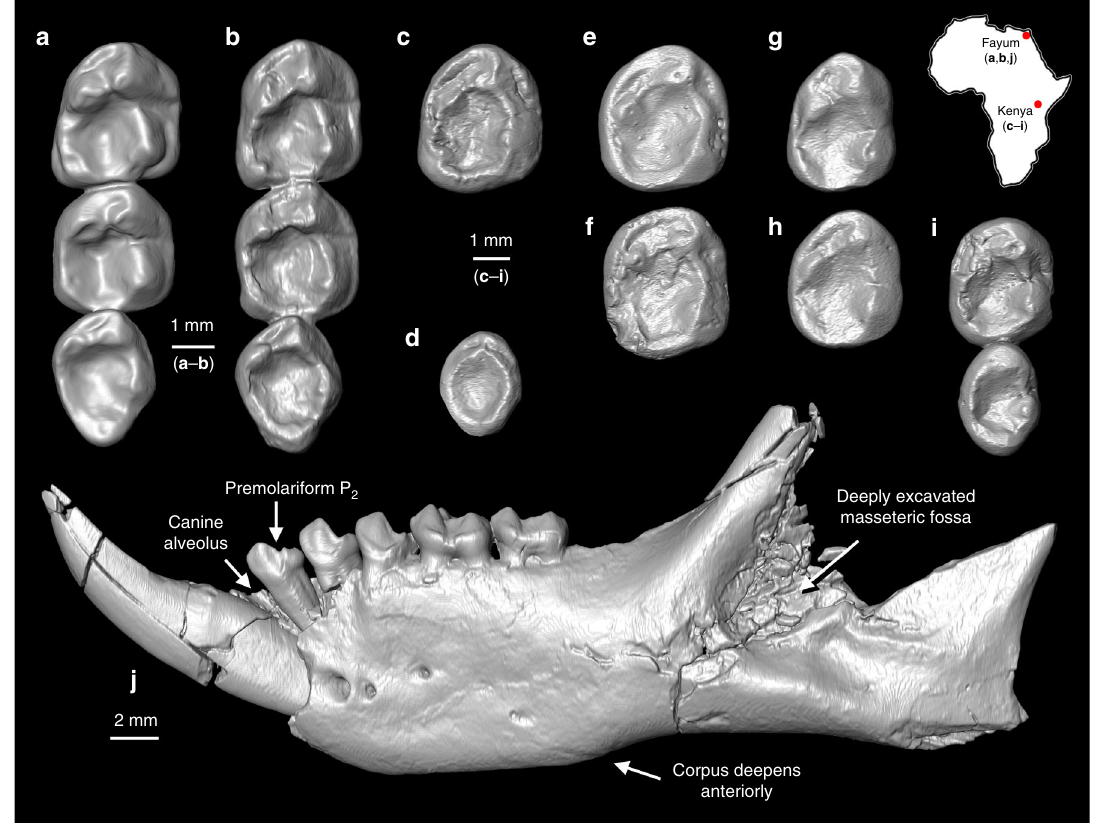
Fig. 1 Comparison of lower molar morphology of latest Eocene Plesiopithecus teras and early Miocene Propotto leakeyi and mandibular morphology and lower dentition of Plesiopithecus teras . a M 1 – 3 of DPC 11636, left mandible of Plesiopithecus teras (reversed for comparison, latest Eocene, Quarry L-41, Fayum Depression, Egypt); b M 1 – 3 of CGM 42291, holotype right mandible of Plesiopithecus teras ; c Left M 1 of KNM-RU 1879, mandible of Propotto leakeyi